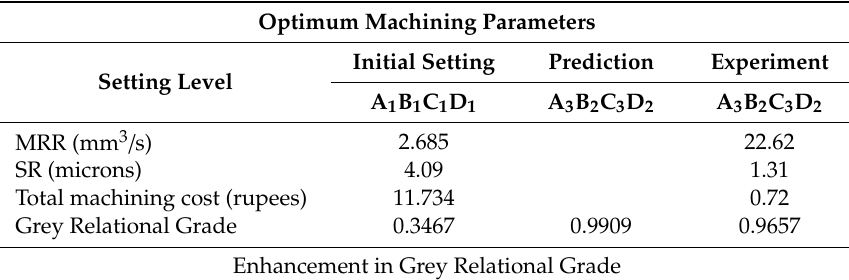
Table 11. Confirmation test results for the CNC turning of LM 25 alloy.